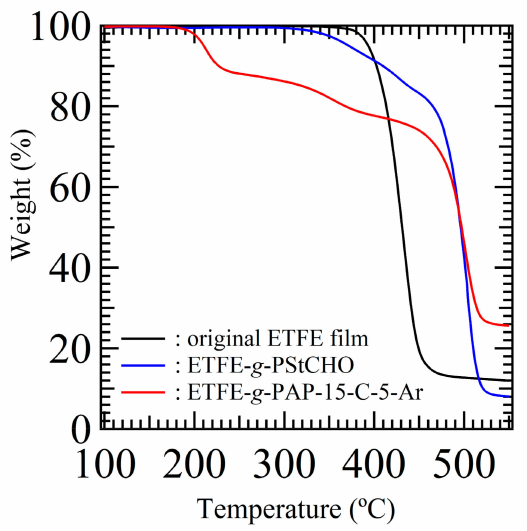
Figure 5. Thermogravimetry-di ff erential thermal analysis (TG-DTA) profiles of the original ETFE film, the ETFE- g -PSt-CHO, and ETFE- g -PAP-15-C-5-Ar.